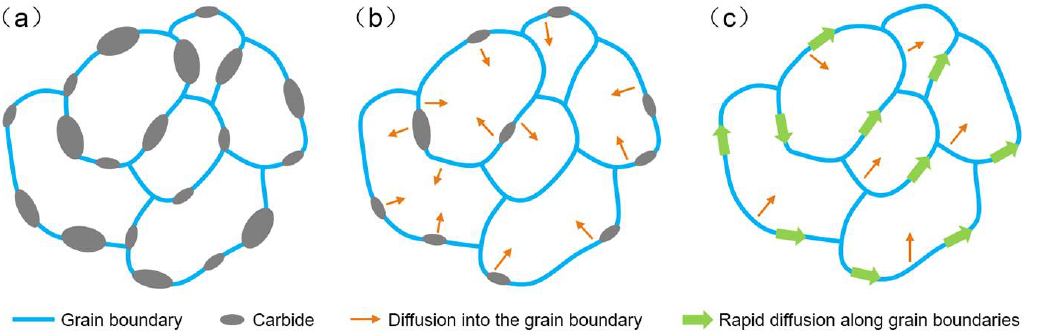
Figure 14. Simulation of new solid-solution carburization: ( a ) in the presence of network carbide conditions; ( b ) the dissolution process of network carbides; ( c ) rapid diffusion of carbon atoms along grain boundaries.